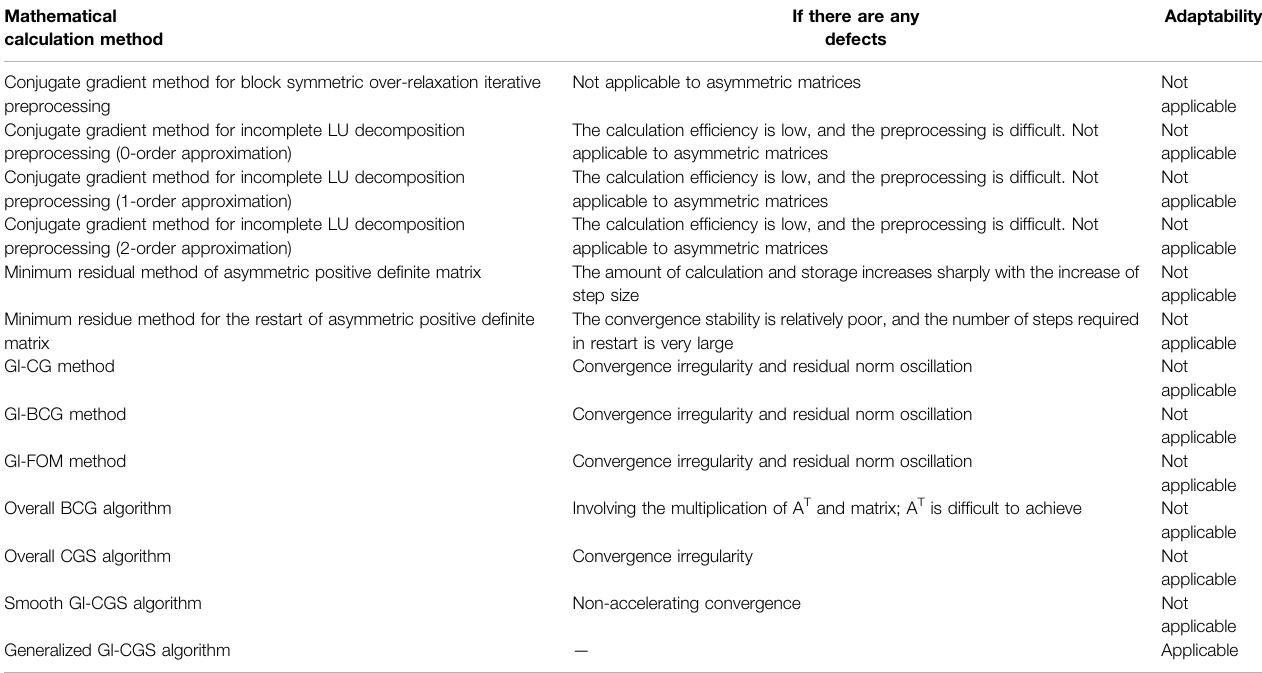
TABLE 1 | The adaptability analysis of the different matrix solving methods.